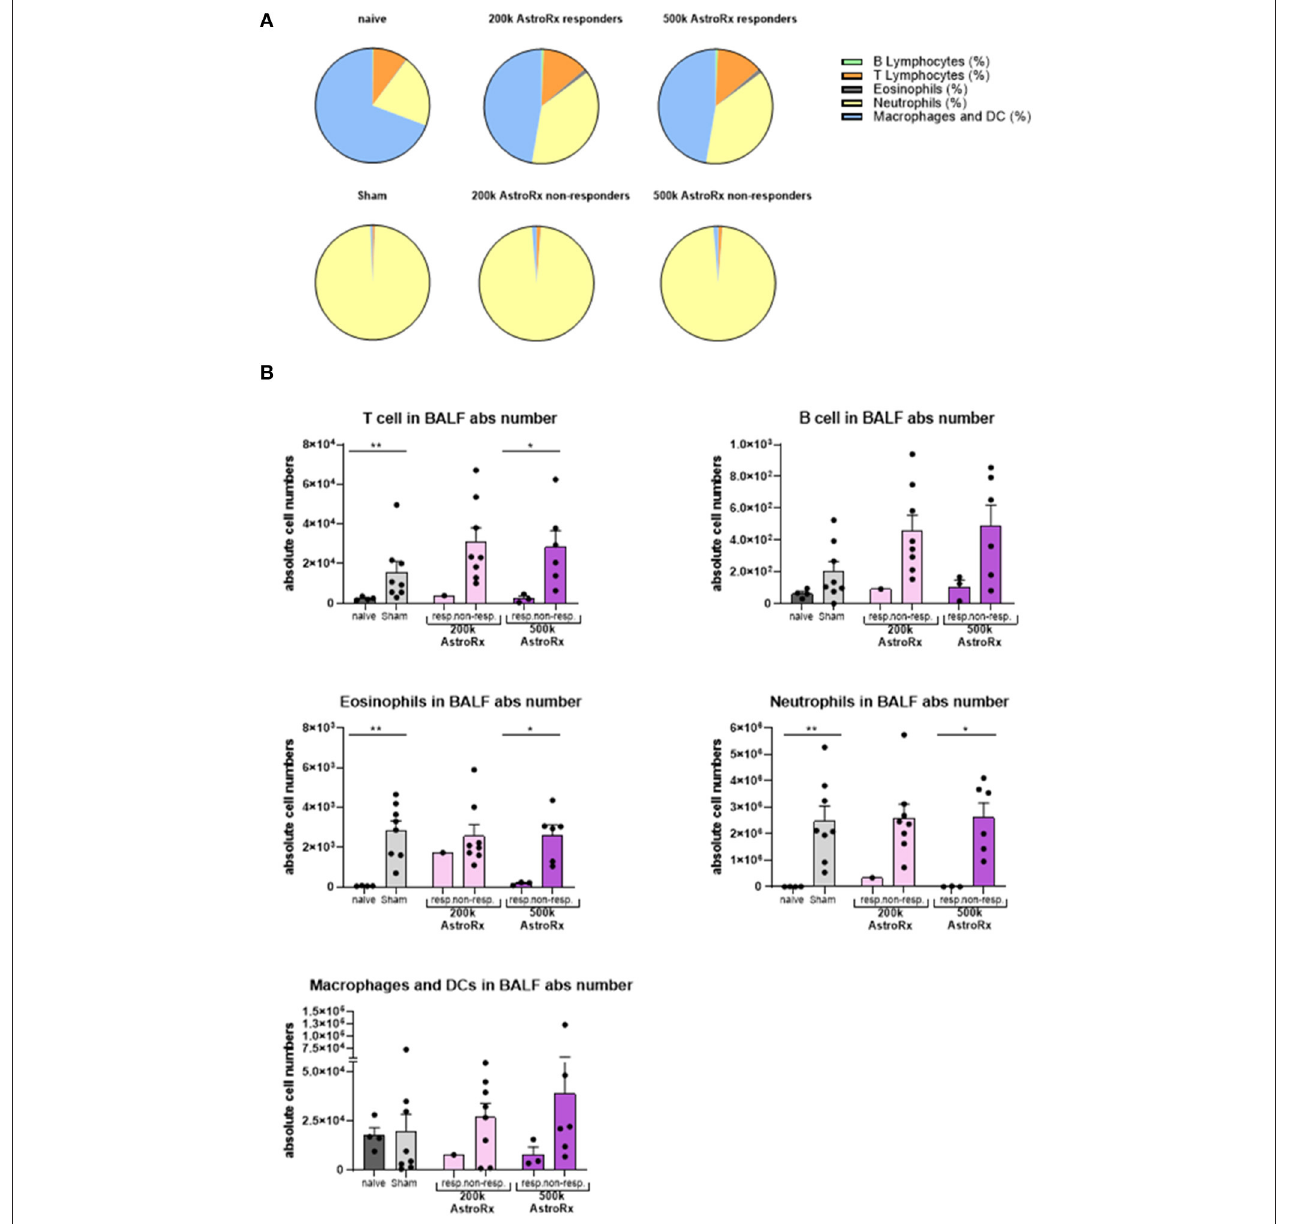
FIGURE 4 | Responder mice maintain immune homeostasis in the lungs after AstroRx treatment. Bronchoalveolar lavage was analyzed by flow cytometry for the immune cells. (A) The composition of cells in the BALF of responders and non-responders after AstroRx treatment. (B) An absolute number of immune cells in the BALF. The value of n = 10 mice for each experimental group (sham and both the groups of AstroRx treated mice) and n = 4 for naïve mice, the results are expressed as mean ± SEM. The Mann–Whitney comparison test. * p < 0.05; ** p < 0.01; Naïve vs. sham: ** p = 0.0081 (T cells), ** p = 0.0040 (eosinophils and neutrophils), 500k responders vs. non-responders: * p = 0.0286 (T cells, eosinophils, and neutrophils).